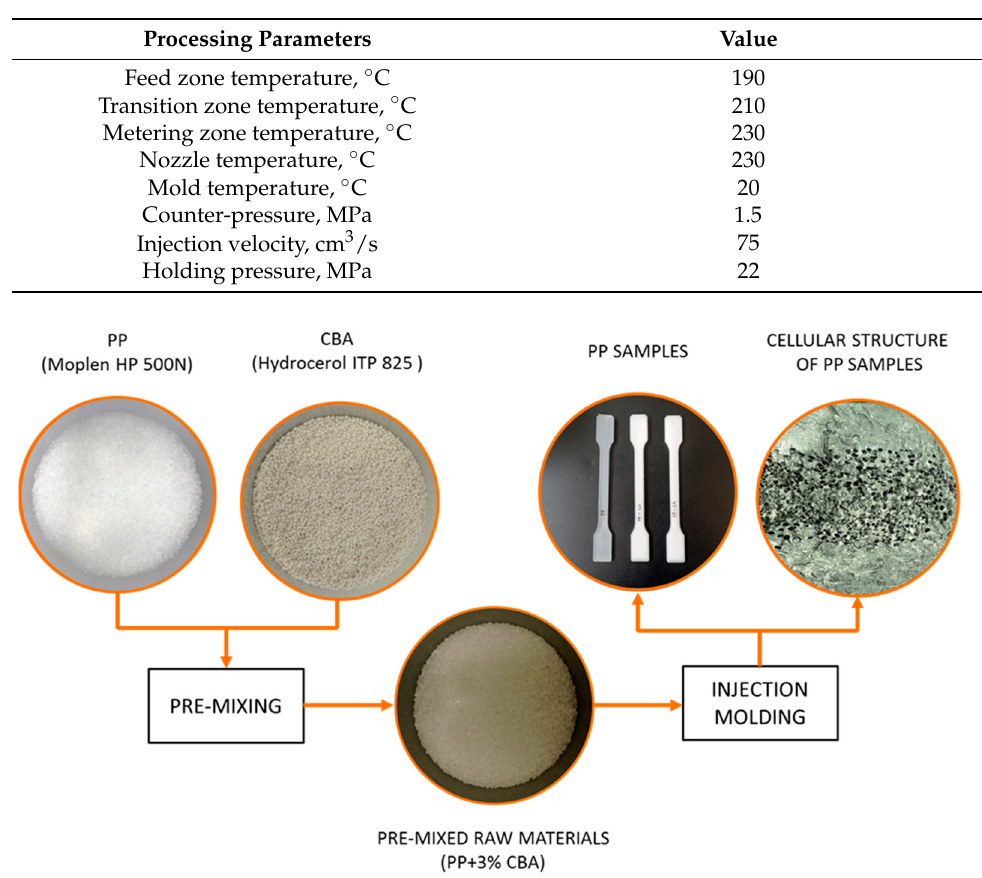
Figure 3. Sample preparation process .